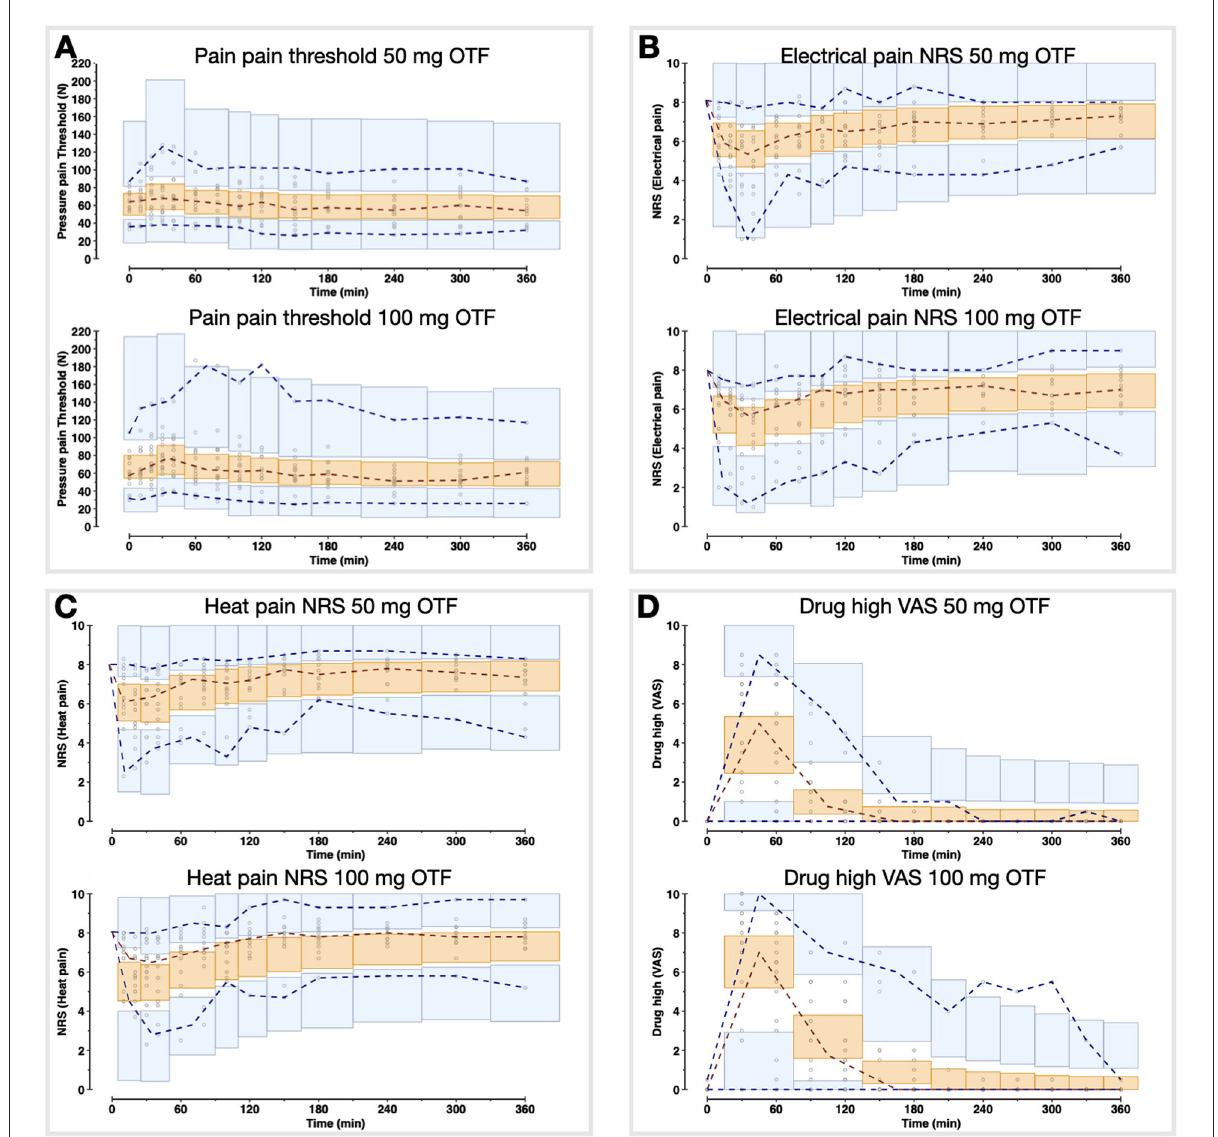
FIGURE5 Visual predictive checks of the pharmacodynamic model for the two S- ketamine OTF doses. The circles are the measured data points; the broken lines are the observed percentiles (dark red: median, dark blue: 2.5th and 97.5th percentiles); the bins are the 95% confidence intervals of simulated percentiles (orange bins: median, blue bins: 2.5th and 97.5th percentiles). (A) Pain threshold; (B) Electrical pain numerical rating scale (NRS); (C) Heat pain NRS; (D) Drug high visual analog scale